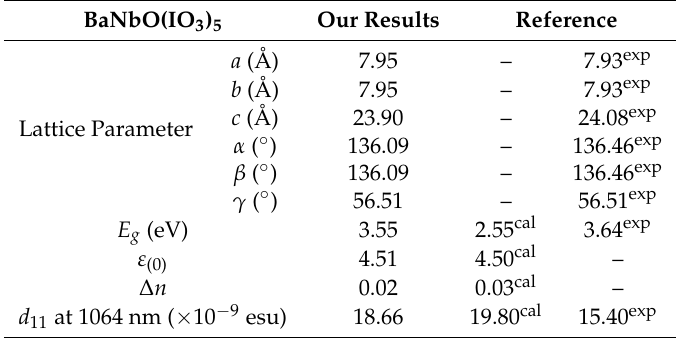
Table 1. The lattice parameters, electronic and optical properties of BaNbO(IO 3 ) 5